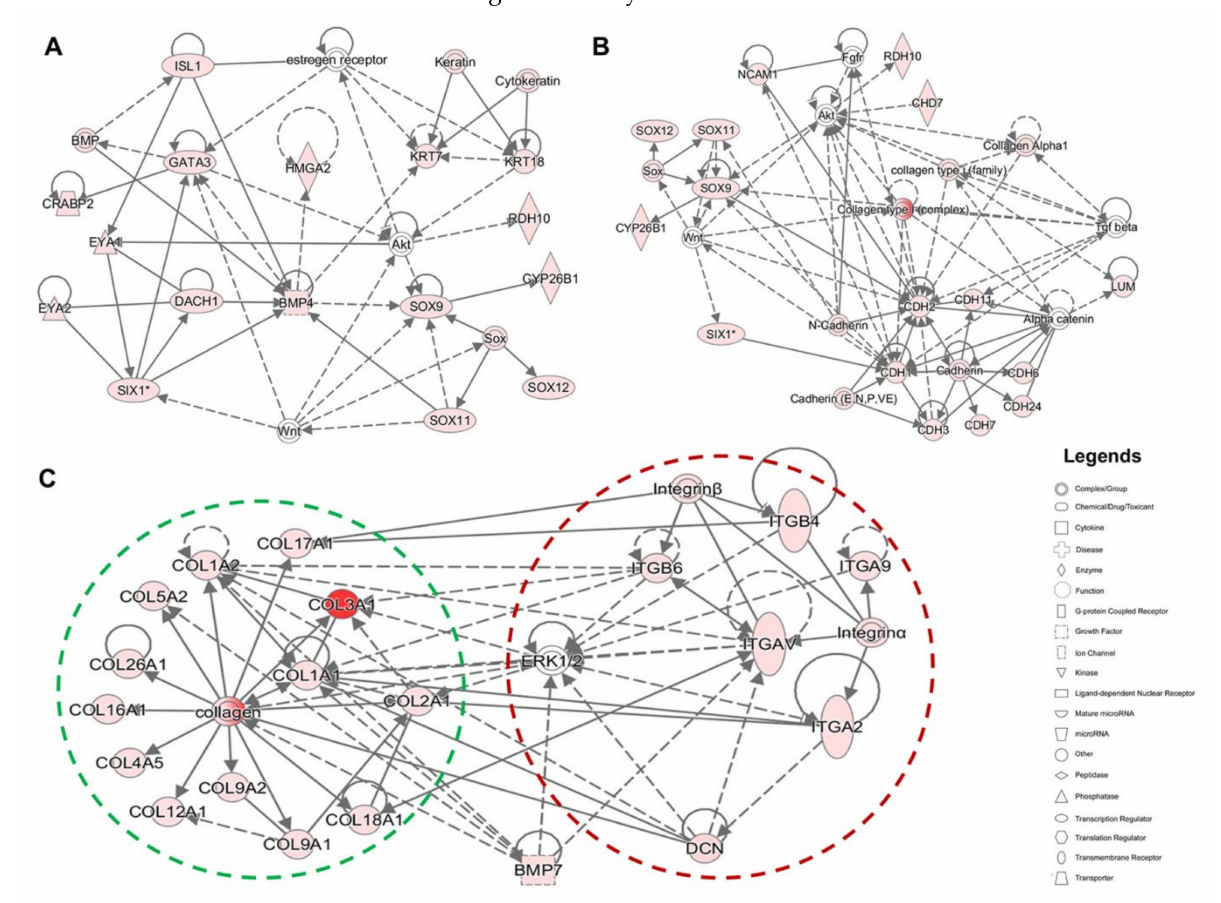
Figure 7. Functional network analysis of upregulated genes during the time course of human otic sensory differentiation in vitro. ( A , B ) The most significant IPA network assembled around otic/placodal gene ( EYA1 , SIX1 , DACH1, etc.) markers and their direct and indirect interactions with SOX ( SOX9 , SOX11 ), RA ( CYP26B1 , RDH10 ) and HMGA2 genes in day 13 differentiated cell cultures. ( C ) The most significant IPA network assembled around ECM and their cellular integrin receptors (ITG) in day 13 cultures showing the networks of COL1A1 and COL2A1 and their close interactions with other Collagen and DCN genes. Furthermore, the network showed additional direct and indirect interactions between ECM and ITG genes. ERK1/2 and BMP7 genes displayed both ECM and ITG indirect interactions. Nodes shaded in pink represent protein-coding genes that are upregulated in day 13. The intensity of the node color indicates the degree of up-regulation. Edges (lines) and nodes are annotated with labels that illustrate the nature of the relationship between genes and their functions. A solid line represents a direct interaction and a dotted line an indirect